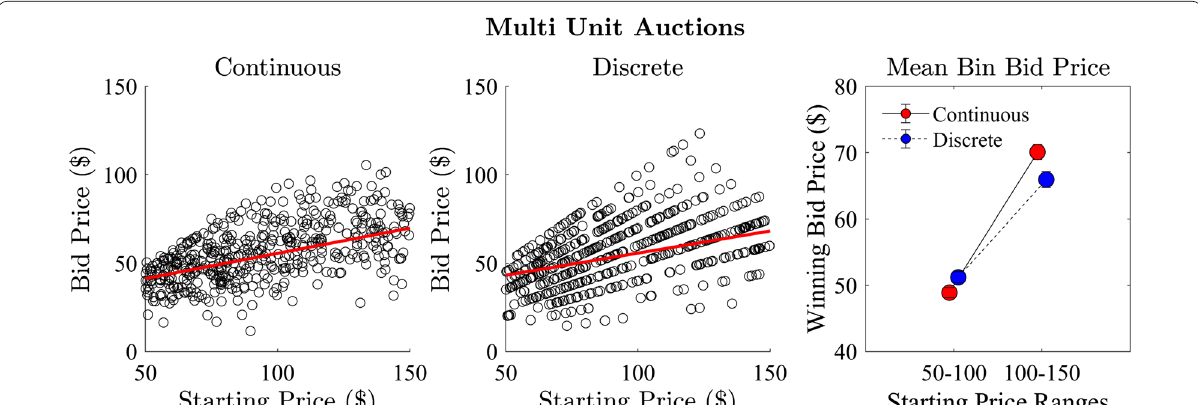
between blocks, suggesting winning bids did not change across blocks in either of the step-rate conditions as par- ticipants gained auction experience.